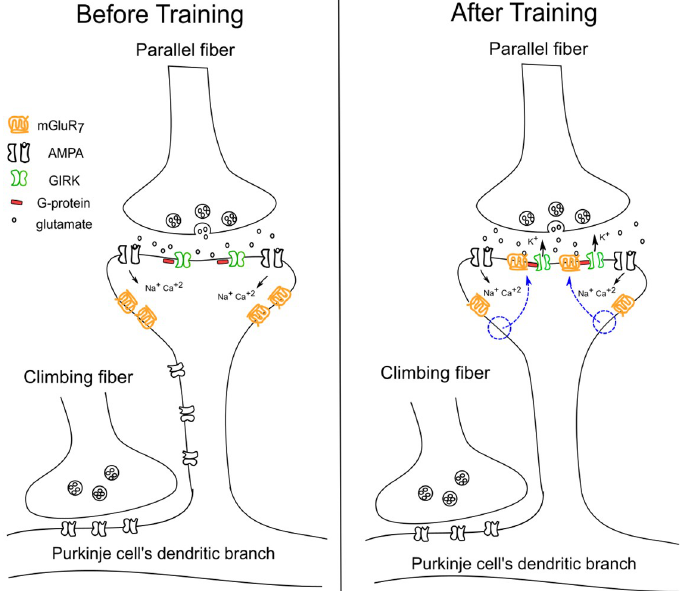
Fig 1. mGluR 7 receptor distribution before and after conditional training in the Purkinje cell. Before training, mGluR 7 receptors are localised at perisynaptic areas of the synapses. After training, as pointed out by the blue arrows, these receptors localised themselves at the postsynaptic area of the synapse via CME.